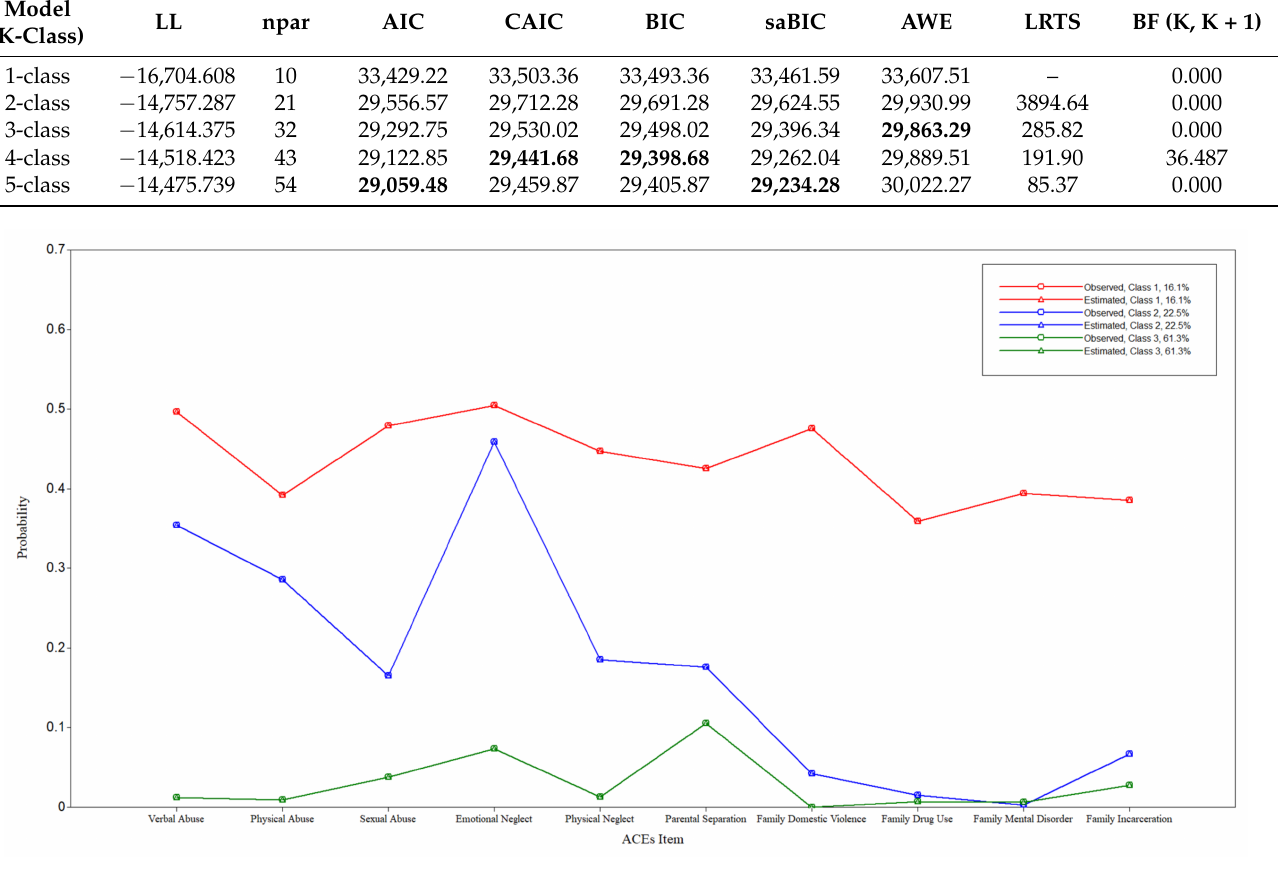
Figure 1. Three-Class Model.